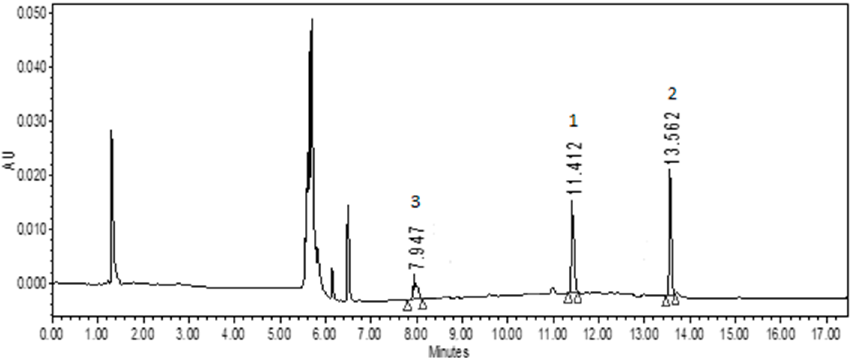
Figure 2. UHPLC chromatograms of pure auraptene 1 , umbelliprenin 2 , and umbelliferone 3 in pomegranate seeds ethanolic extract (ultrasound-assisted maceration, 1 min.).